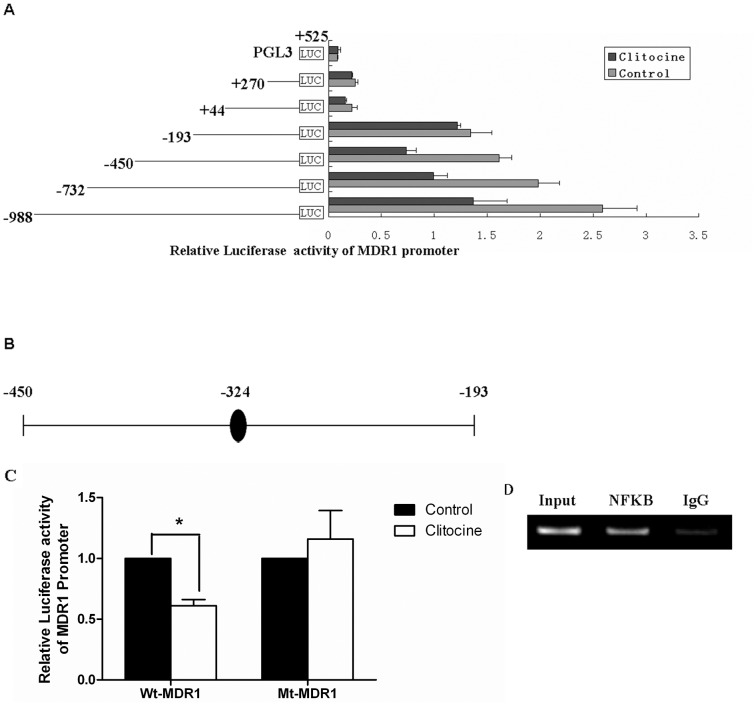
Truncation analysis of the MDR1 promoter with clitocine treatment.(A) The relative luciferase activity of 5′-end truncated MDR1 promoters was detected by Dual-Luciferase Reporter Assay System. R-HepG2 cells were transiently transfected with the truncated MDR1 promoter reporters followed by treatment with 0.2 µM clitocine for 24 h. After that, the cells were lysed and the luciferase activity was measured. Data are mean ± SD, N = 8. (B) Computational analysis of the putative transcription factor binding sites in the full length MDR1 promoter was performed. A single consensus binding site for transcription factor NF-κB was identified in the region −450 to −193. (C) R-HepG2 cells were transiently transfected with wild type (WT) and mutated type (MT) full length (−988∼+525) MDR1 promoter reporter followed by treatment with 0.2 µM clitocine in R-HepG2 cells for 24 h. After that, the cells were lysed and the luciferase activity was measured. Data are mean ± SD, N = 4. *
P<0.05 vs. control. (D) Immunoprecipitaition (CHIP) assay was performed as described in Materials and Methods. Chromatin from R-HepG2 cells was cross-linked, sheard and immunoprecipitated with anti-NF-κB p65 antibody. Normal rabbit IgG was included as the negative control (IgG) and the input DNA from fragmented chromatin before immunoprecipitation was used as internal control. The recovered chromatin was subjected to PCR analysis using primers covering the putative NF-κB binding motif of the MDR1 promoter and the PCR products were resolved in 1.5% agarose gel. A representative experiment is shown, and similar results were obtained from three independent experiments.